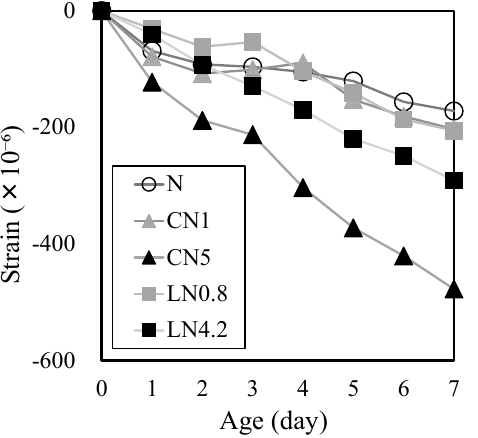
Figure 7. Drying shrinkage (up to 7 days).